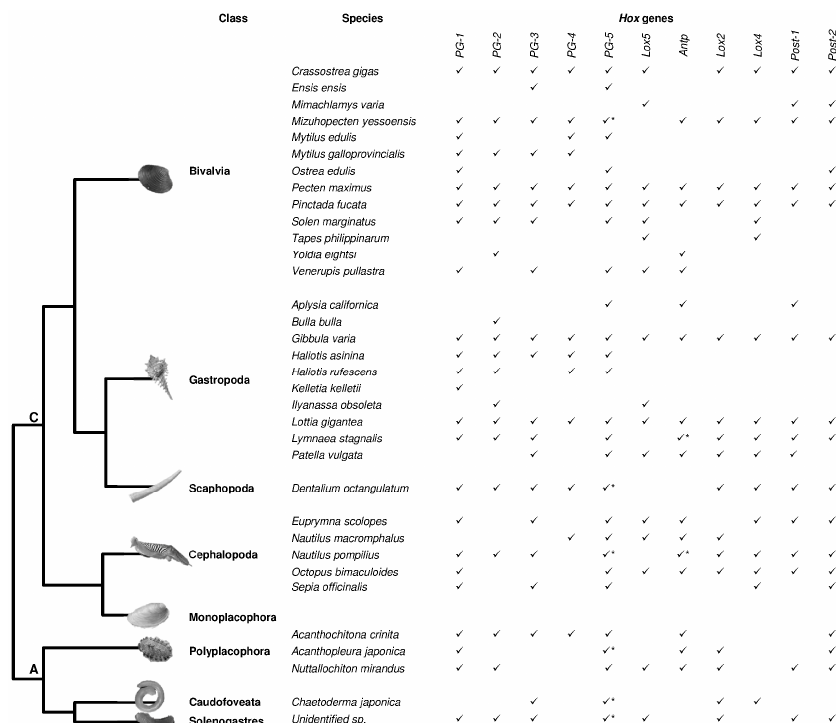
Figure 1. Hox genes in Mollusca. Hox genes identified in the Mollusca phylum are reported. Tree topology following Smith et al. [92,93]. C: Conchifera; A: Aculifera.* indicates duplicated genes probably due to erroneous attribution [94]. The graphics of the figure were modified from Biscotti et al. [94]. For references see Table S1.